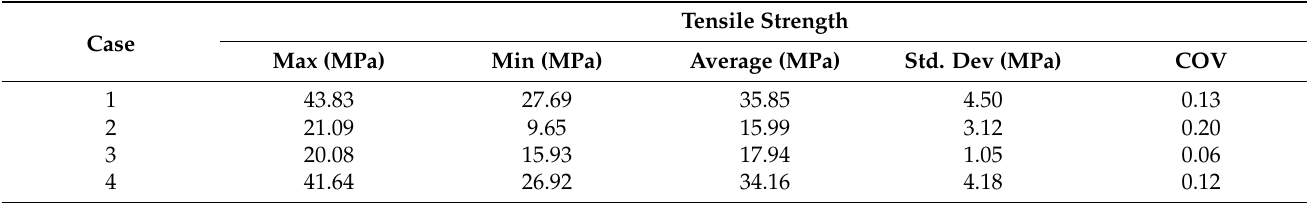
Table 5. Results of tensile tests for Cases